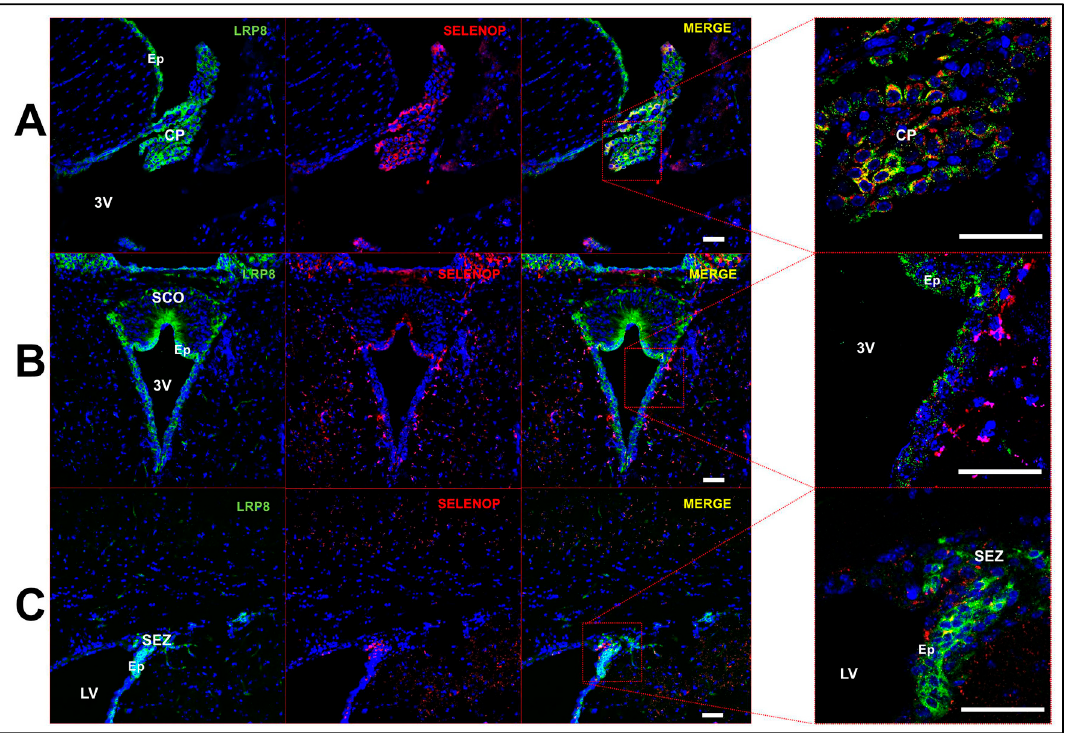
Figure 4. Expression of SELENOP and LRP8 in brain ventricles. ( A ) Confocal images of mouse choroid plexus showing expression of LRP8 (left), SELENOP (middle left), and merged images at low (middle right) and high magnification (right). ( B , C ) Images showing expression of LRP8 and SELENOP in the vicinity of the 3rd ( B ) and lateral ventricle ( C ). Abbreviations: 3V: 3rd ventricle; CP: choroid plexus; Ep: ependymal cell layer; LV: lateral ventricle; SEZ: subependymal zone. Scale bar = 50 μ m.